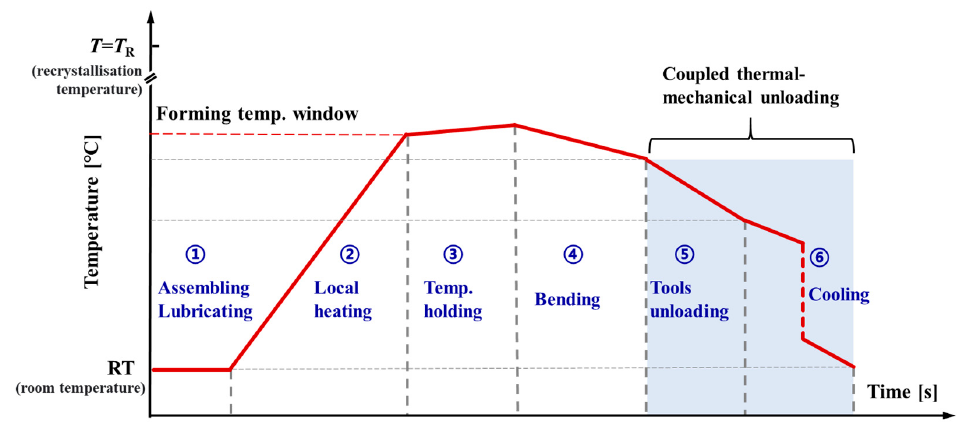
Figure 2. Thermal-mechanical solution for local heat-assisted bending.